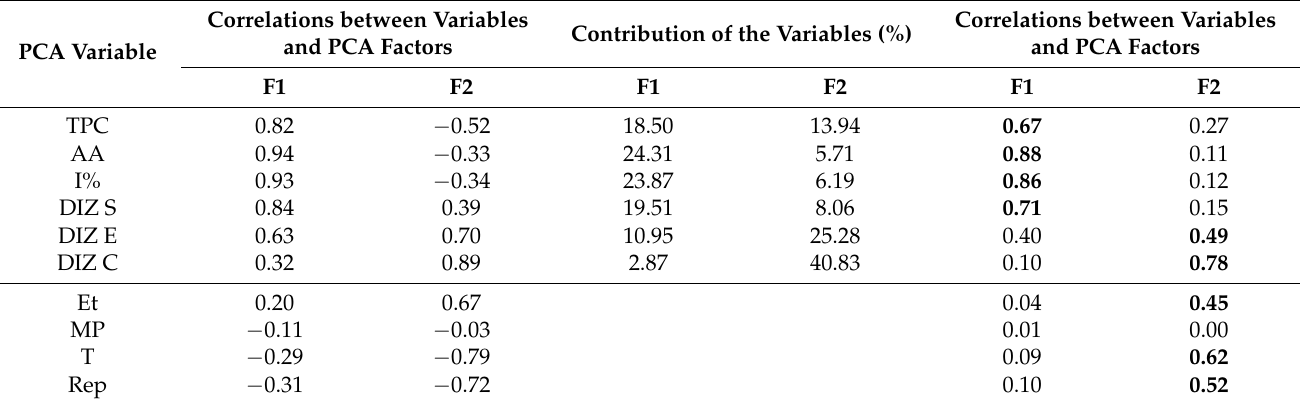
Table 4. Correlations between variables and principal component analysis (PCA) factors, contribution of the variables and squared cosines of the variables.